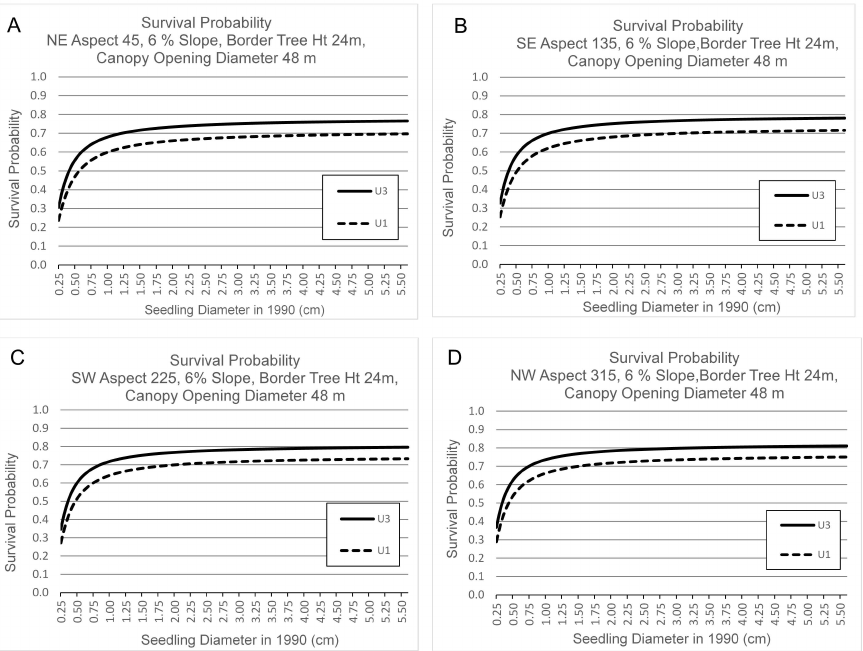
Figure 1. The relationship between seedling diameter, survival probability and understory treatment (U3 is understory treatment with an herbicide applied to cut stems, U1 refers to no understory treatment). ( A )–( D ) With 6% slope, canopy border tree height of 24 m, and canopy opening diameter of 48 m. ( A ) Northeast aspect. ( B ) Southeast aspect. ( C ) Southwest aspect. ( D ) Northwest